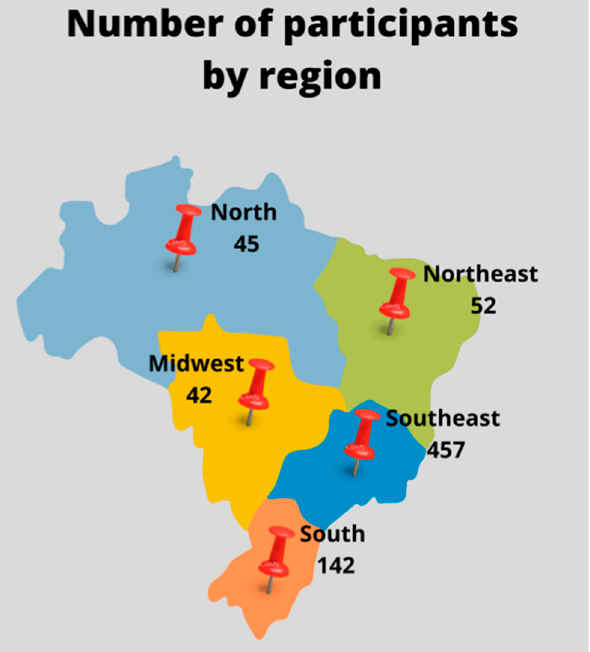
Figure 1. Brazilian map showing the distribution of the 738 Brazilians attendees at the 32nd SBV Annual Meeting. Each Brazilian region is represented by a different color and the number of attendees per region is shown. In total, 23 attendees were foreign and are, therefore, not represented on the map.